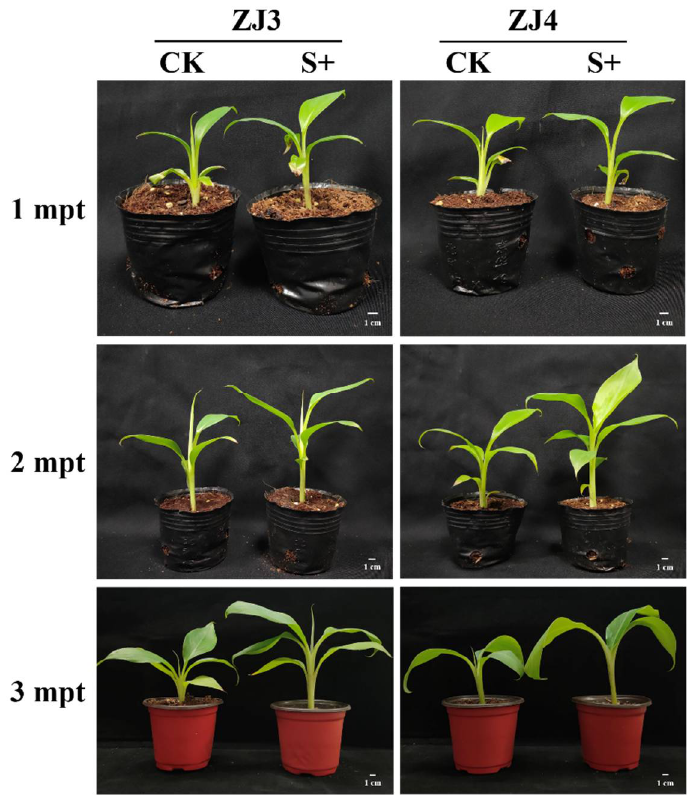
Figure 3. Effects of S. indica on the growth of ‘Zhongjiao No.3’ (ZJ3) and ‘Zhongjiao No.4’ (ZJ4) banana seedlings. CK: S. indica non-colonized controls; S+: S. indica colonized banana seedlings; mpt: months post-transplanting.